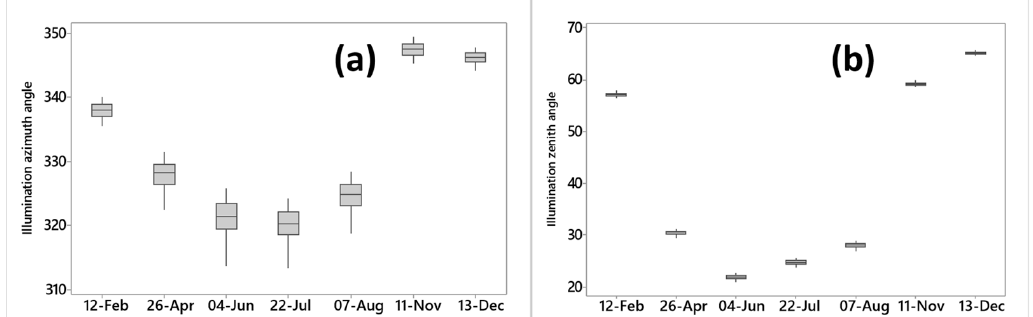
Figure 4. Graphs of the temporal evolution of zenithal angles and solar azimuthal angles. Data are extracted from seven MISR scenes using the same pixels. ( a ) Illumination azimuth angle box plot; and ( b ) illumination zenith angle box plot.